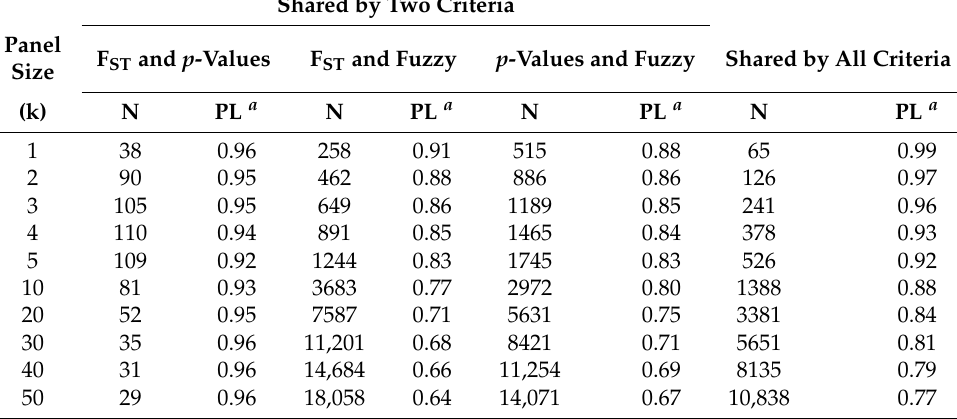
Table 6. The number of shared SNPs and proportion of shared SNPs that are linked with causative variants for F ST score, p -value, and fuzzy score preselection under a genetic architecture of 5 k causative variants.